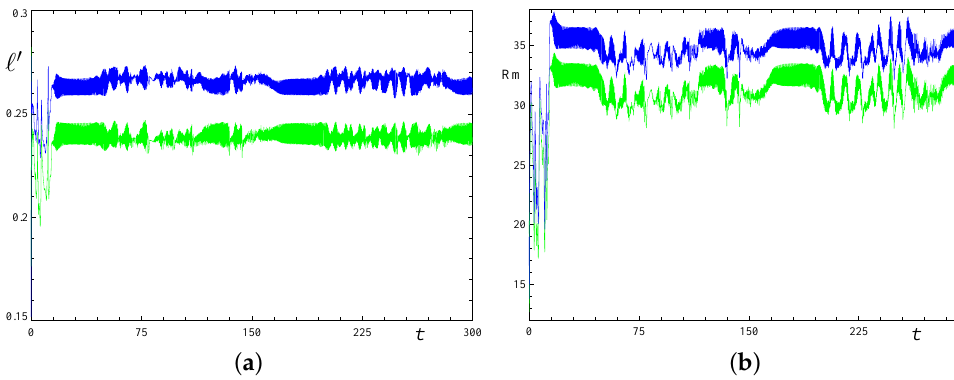
Figure 4. Temporal behaviour of the time-dependent estimates of the length scales (7), (cid:96) (cid:48) and (cid:96) (cid:48) (blue line), (a), and of the magnetic Reynolds number, Rm (cid:48) 3 run 1 x 2.2